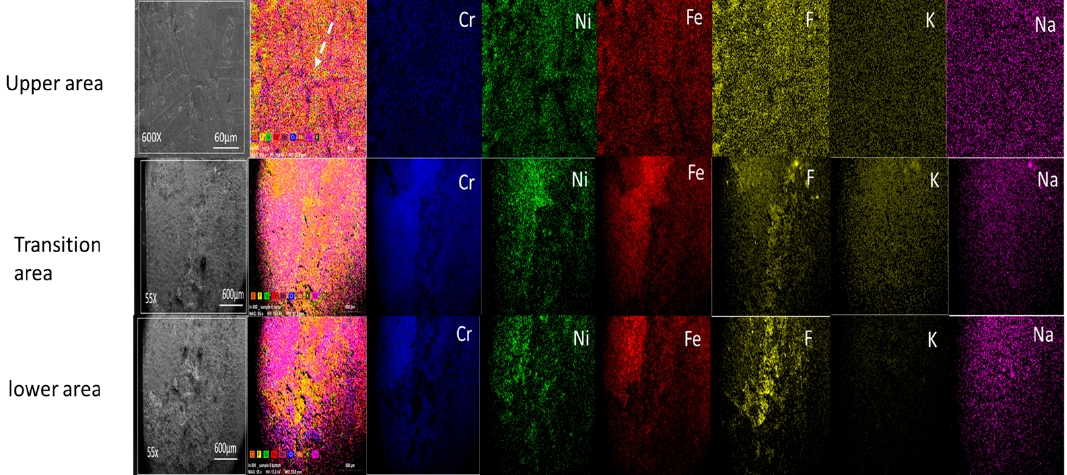
Figure 7. Surface mapping of Incoloy ® -800H. The image also shows grain boundary in the upper area, as indicated by the white arrow.